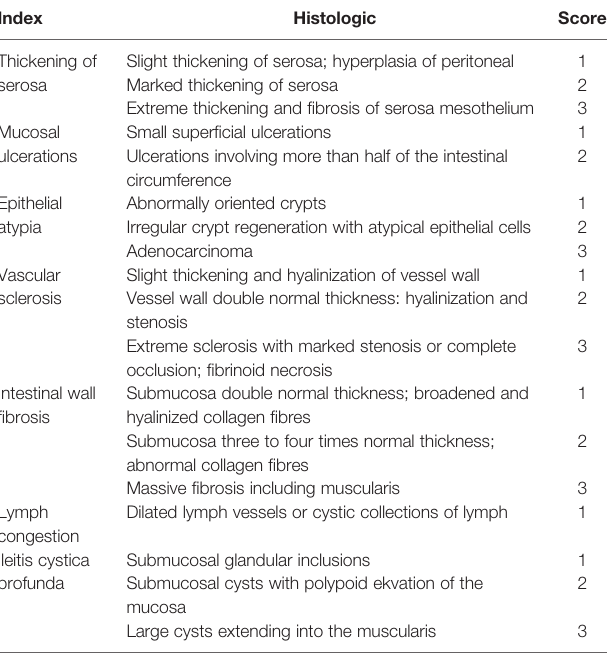
TABLE 1 | Histopathologic changes used in the calculation of the radiation injury